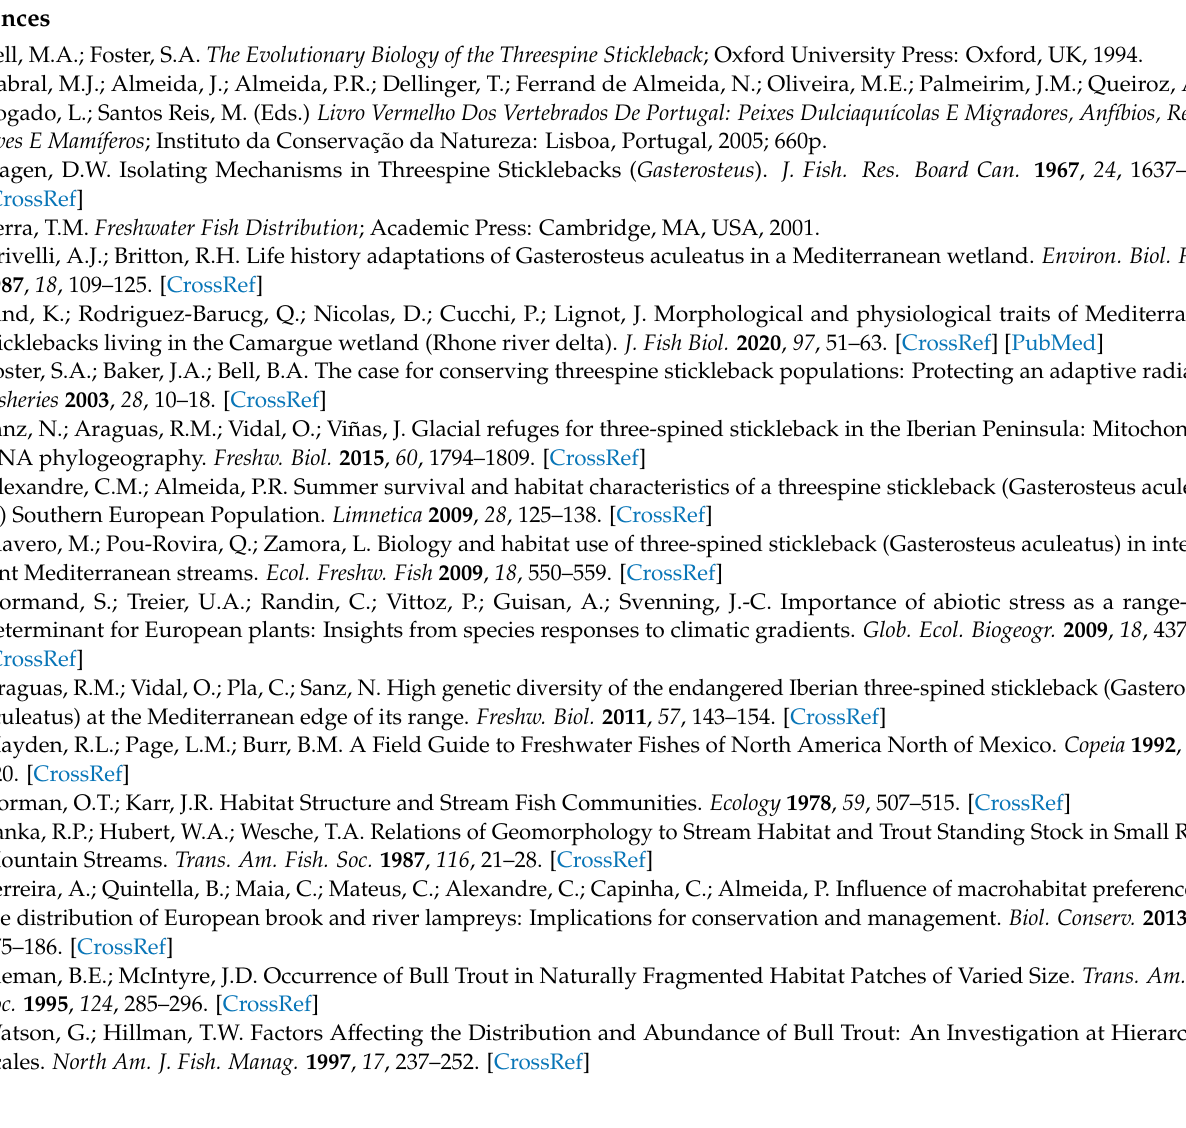
Figure A1 . Relative importance of each considered environmental variable in explaining the distribution and occurrence of G. aculeatus .